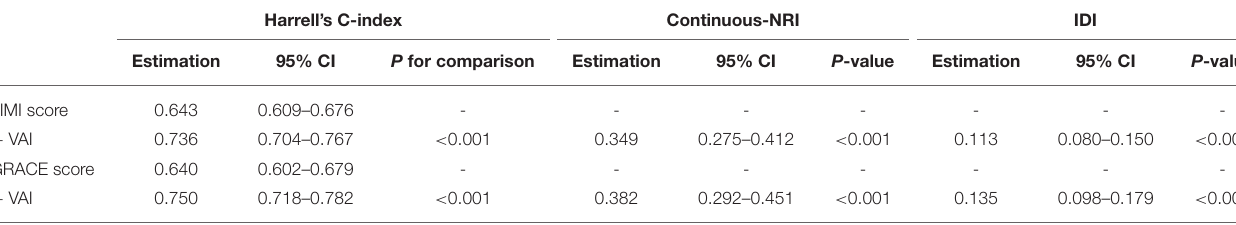
TABLE 6 | Incremental effects of VAI on risk stratification for the primary endpoint beyond existing risk